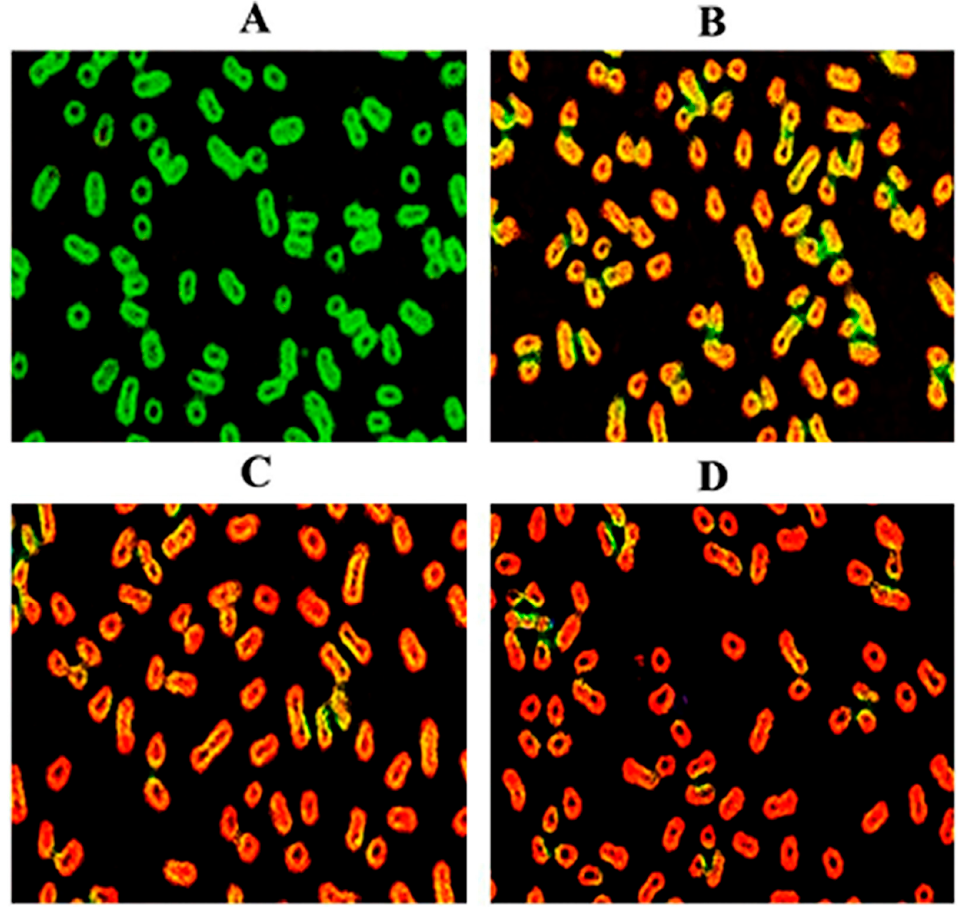
Figure 7. Green and red fluorescence-stained E. coli micrographs. ( A ) Non-treated E. coli , ( B ) E. coli treated with ZnO NPs, ( C ) E. coli treated with Au NPs, and ( D ) E. coli treated with Au/ZnO NCs (100×).